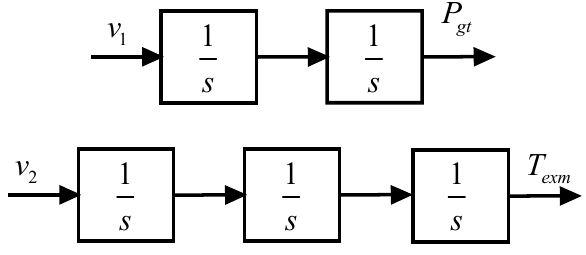
Figure 3. Equivalent relation between fictitious inputs and the controlled quantities.